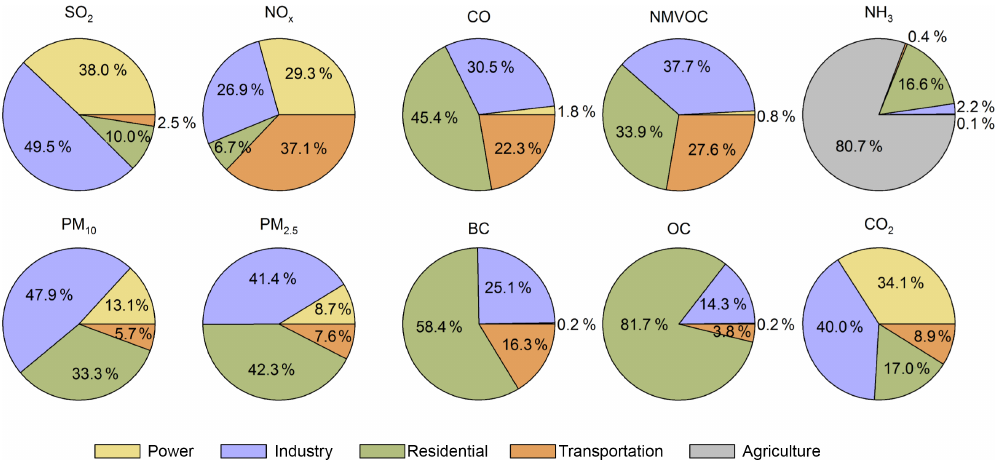
Figure 4. Emission distributions among sectors in Asia in